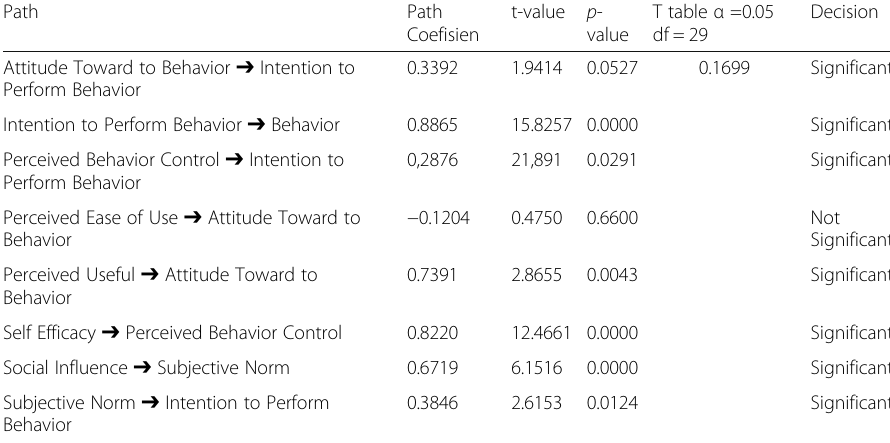
Table 2 Path Coefficient, t -value and p -value